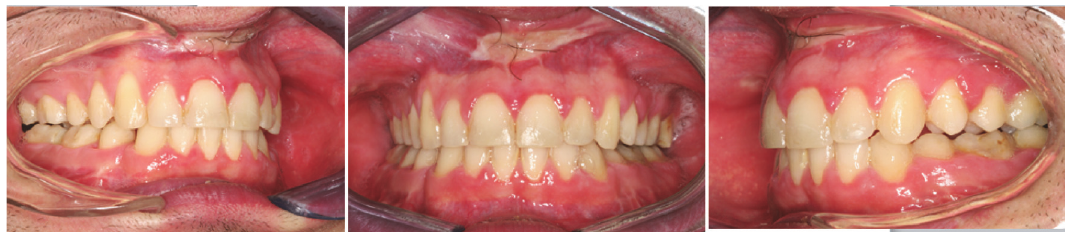
Figure 10: Occlusion after